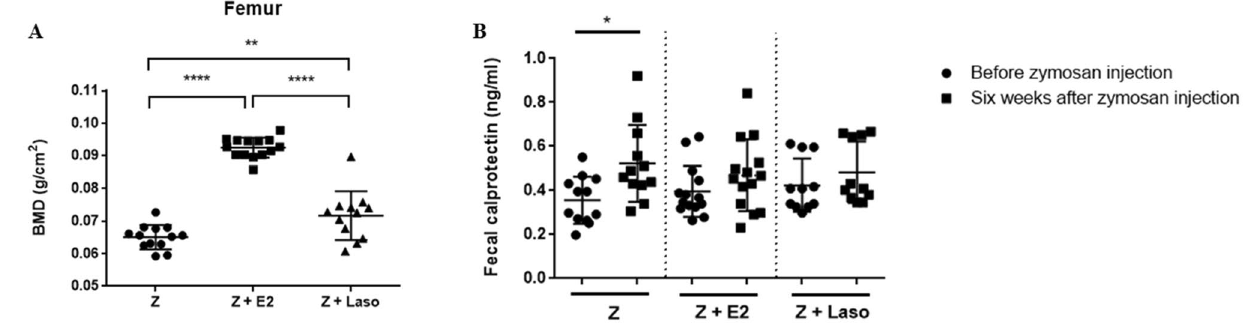
Figure 4. Bone mineral density (BMD) and fecal calprotectin levels between groups. ( A ) BMD was analyzed in femur. ( B ) Calprotectin levels at before zymosan (Z) infection and 6 weeks after Z injection in each group ( n = 12–14 mice per group). Analyses were performed using GraphPad Prism (version 5.0; GraphPad Software Inc., La Jolla, CA, USA, https:// graph pad- prism. softw are. infor mer. com/5. 0/). * p < 0.05, ** p < 0.01, *** p < 0.001,